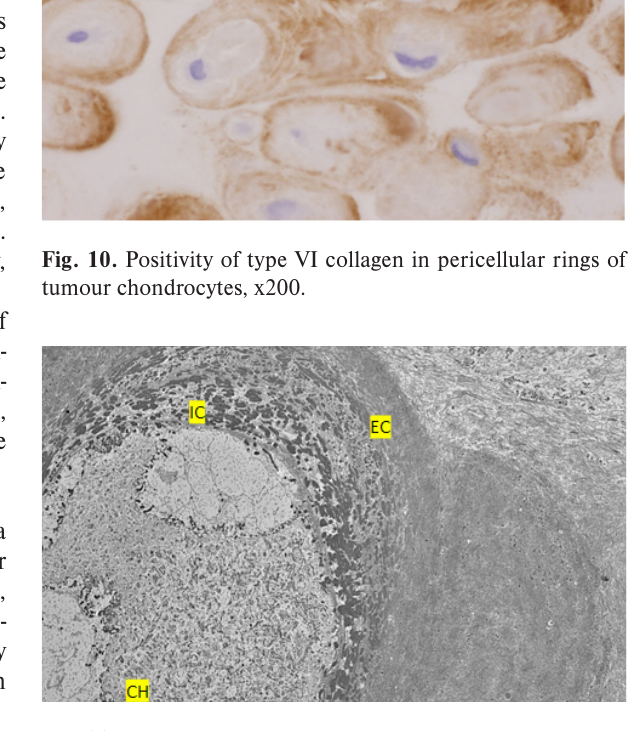
Fig. 11. Electron microscopy of neoplastic target-like chondro- cyte from unusual soft tissue chondrosarcoma. Chondrocyte (CH) is surrounded with thick ring composed of internal (IC) and external EC) component together producing thick capsule. Both components differed in their internal structures. Original magnification x8000.